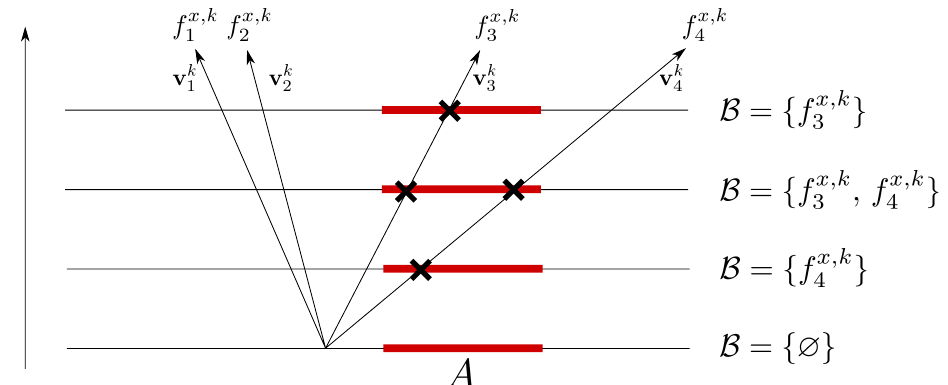
Figure 1: Quasiparticles which contribute to the entanglement entropy at time t .